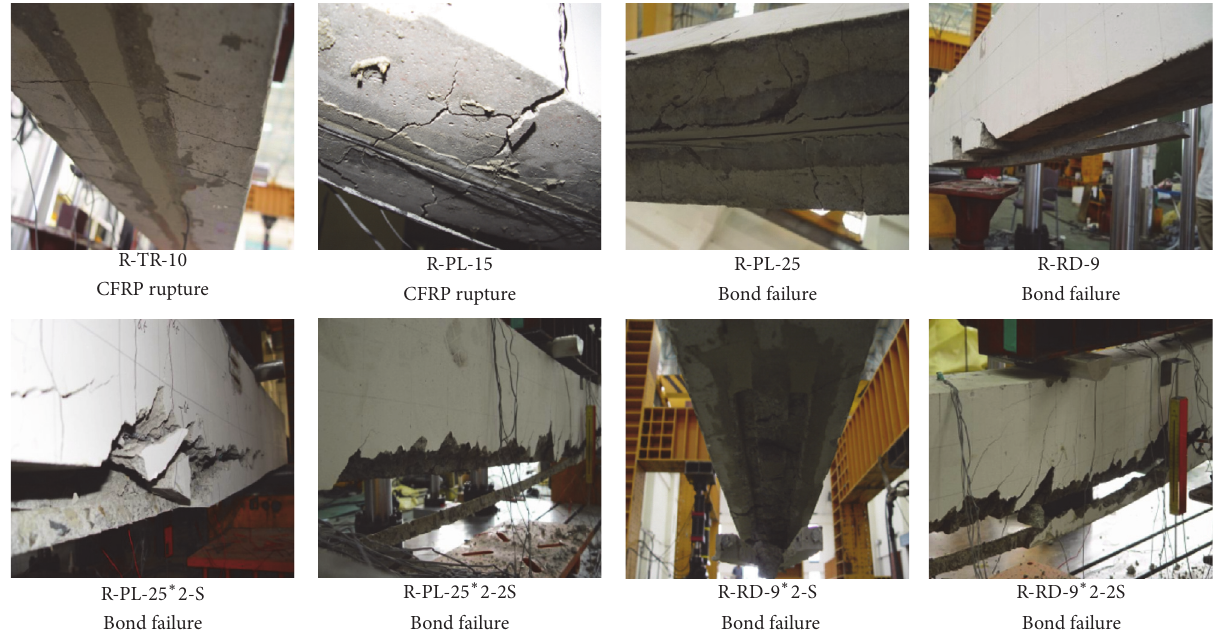
Figure 13: Failure patterns of specimens strengthened by